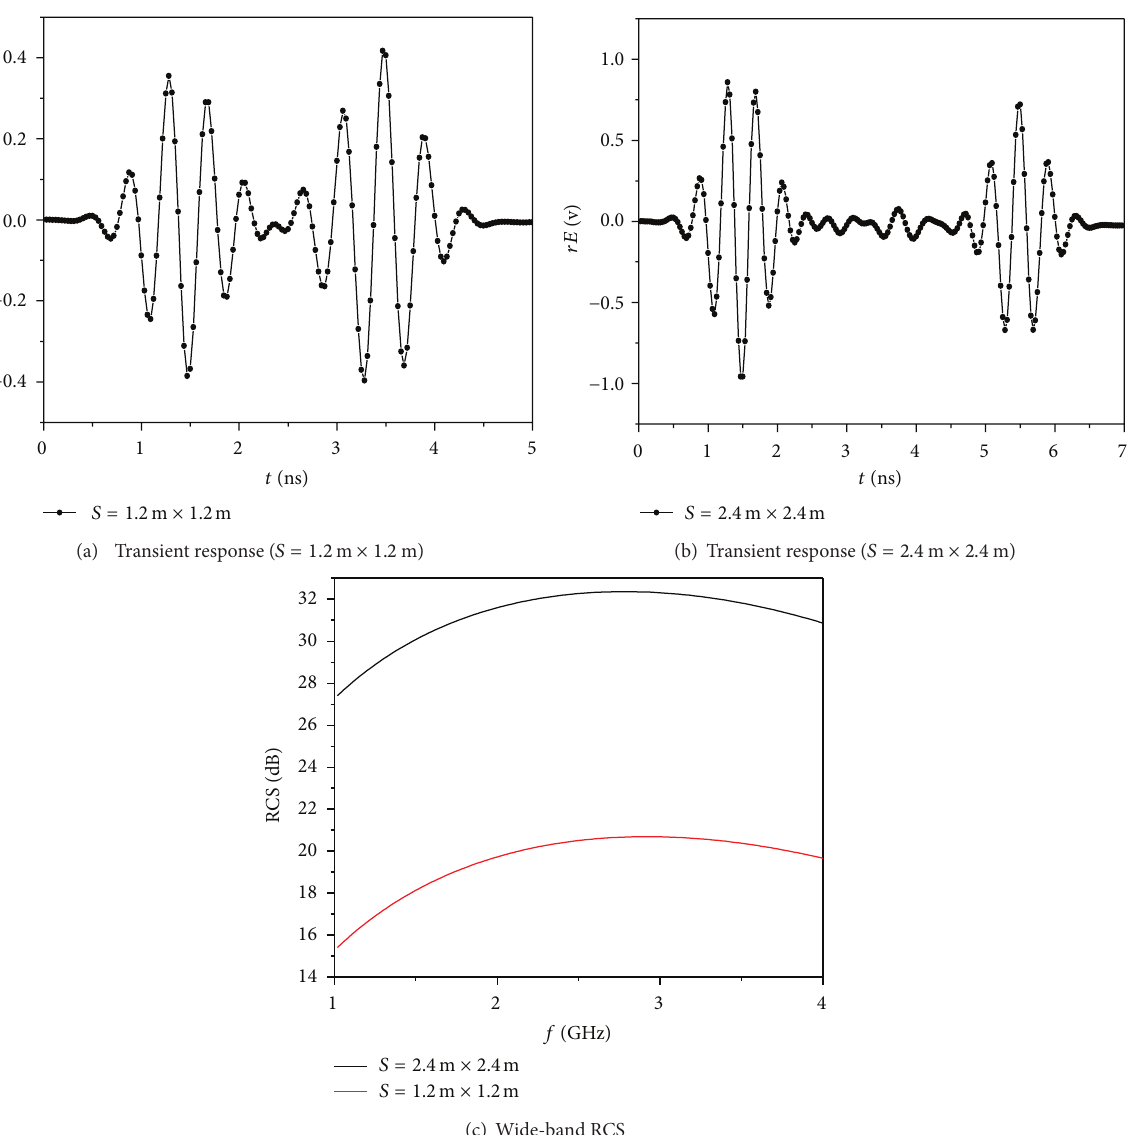
Figure 4: Scattering from 2D rough surface in specular direction for different sizes of rough surface.